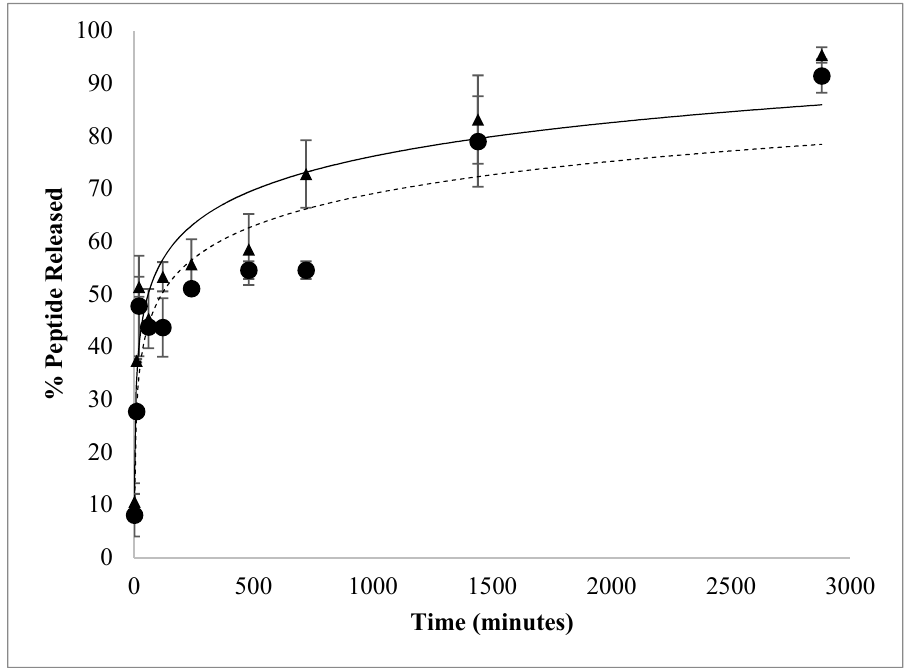
Figure 4. In vitro release of G17NP ( ▲) and G19NP ( ● ). Release profile of polymeric nanoparticles under the same incubation conditions, 37 °C, pH 7.4 and 50 rpm.